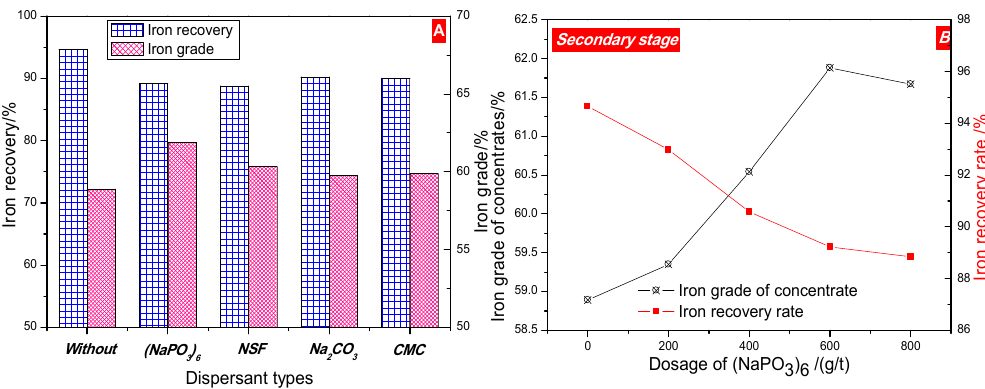
Figure 15. Effects of dispersant on recovery of iron: ( A ) Effect of dispersant types on iron recovery (600 g/t); ( B ) Effect of (NaPO 3 ) 6 addition on iron recovery.